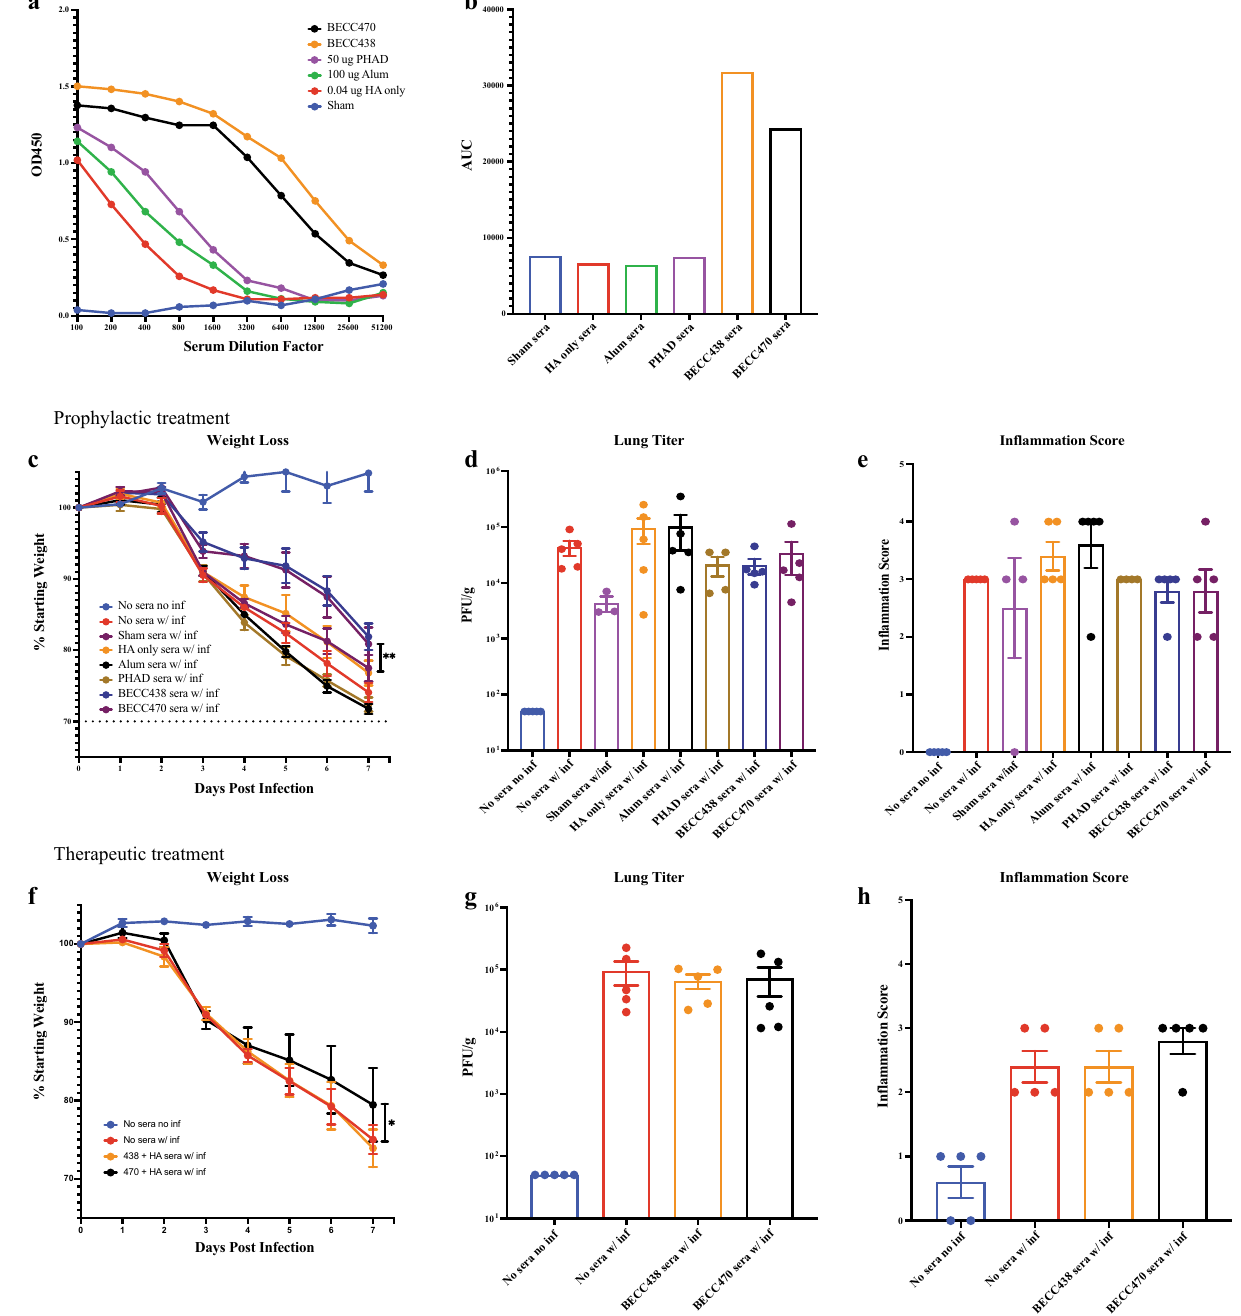
Figure 3. Protection from homologous H1N1 challenge with prophylactic or therapeutic passive transfer of vaccination sera. ( a ) Pooled, day-28 serum H1-specific ELISA total IgG of young adult BALB/c mice vaccinated with 0.04 µg Cal/09 rHA protein in combination with 100 µg alum, 50 µg PHAD 50 µg BECC438 or 50 µg BECC470 adjuvant in prime-boost schedule (mean ± SEM). ( b ) AUC of pooled, pre-infection total IgG antibody titer curve (mean). ( c ) 7-day weight loss (mean ± SEM) of BALB/c mice IP-injected with 100 µL vaccination sera (by group) and infected 2 h later with 3200 PFU NL/09 (**p = 0.008). ( d ) Virus titer (mean + SEM) of mouse lung homogenate in ( c ), 7-days post-infection. ( e ) Pathology inflammation scoring (mean ± SEM) of lung histology slides of mice in ( c ), 7-days post-infection. ( f ) 7-day weight loss (mean ± SEM) of BALB/c mice infected with 3200 PFU NL/09 and IP-injected with 100 µL vaccination sera (by group) at day 1 and day 3 post- infection (*p = 0.0288). ( g ) Virus titer (mean ± SEM) of mouse lung homogenate in ( f ), 7-days post-infection. ( h ) Pathology inflammation scoring (mean ± SEM) of mouse lung histology slides in ( f ), 7-days